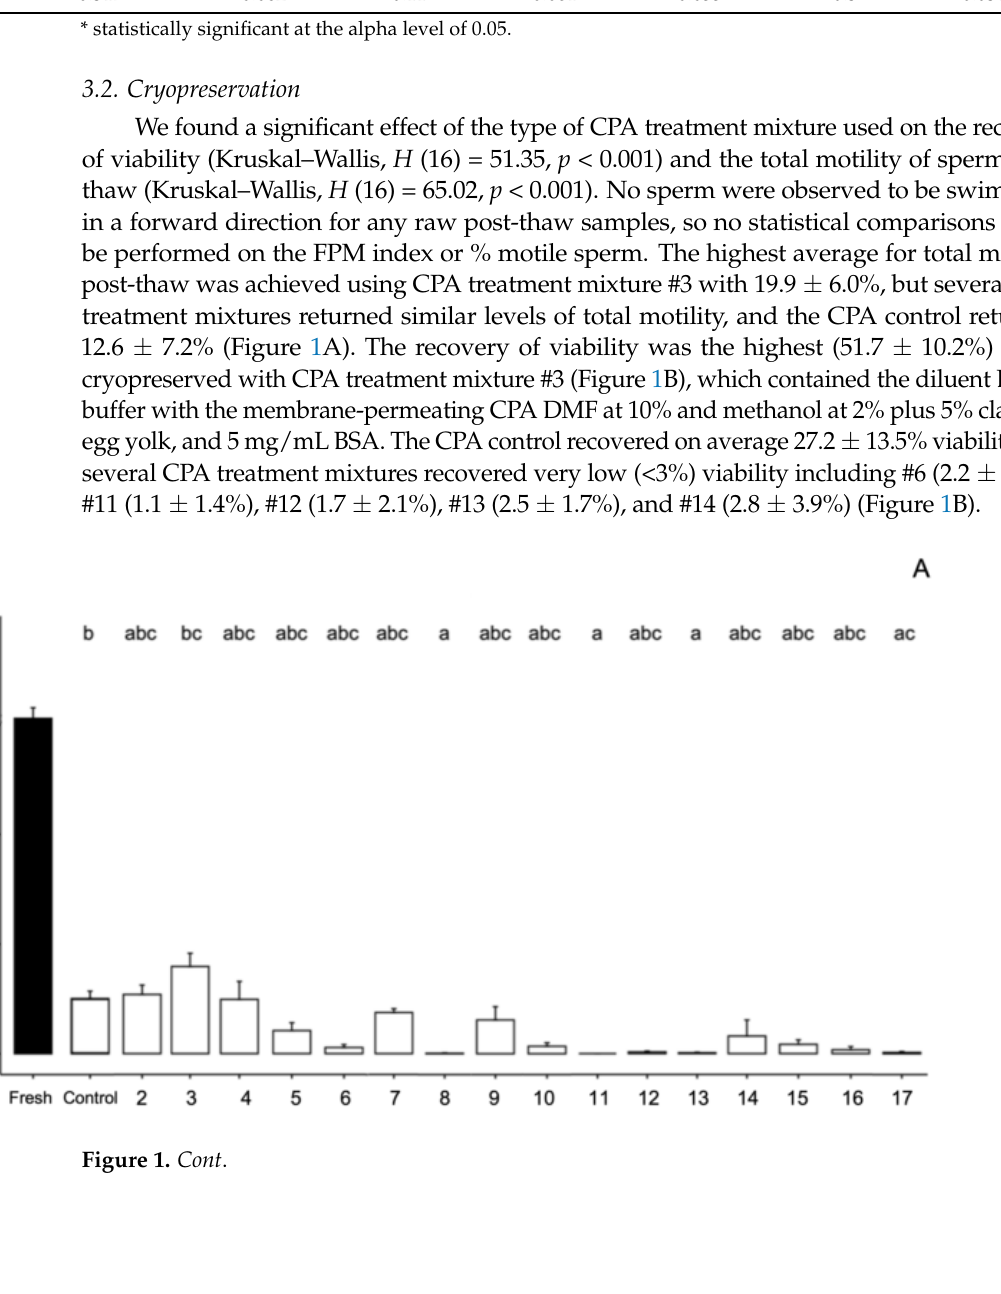
Figure 1. Barplot A: percent total motility of post-thaw sperm of the Louisiana pinesnake cryo- preserved using 17 different CPA treatment mixtures; B percent viability of thawed sperm recov- ered from fresh sperm. Full CPA treatment recipes are reported in Table 1 as final concentrations following a 1:1 dilution (v/v) with semen. Four randomized groupings of males were used to test the CPA control mixture (control) and a set of CPA treatment mixtures (Group A = CPAs #3, 4, 5, 7; Group B = CPAs #2, 14, 15, 16; Group C = CPAs #6, 11, 12, 13; Group D = CPAs #8, 9, 10, 17). We tested CPA mixtures based on three categories of experimental tests: CPA base in TEST = CPA #2; Extender base plus additives = CPAs #3 – 8; and glycerol tests (high vs low) = CPAs #9 – 17). The bars represent the means and standard deviation for each experimental group. Kruskal – Wallis tests for significance followed by Dunn’s post-hoc test with the Benjamini – Hochberg correction for multiple comparisons to compare CPA treatments; alpha was set at 0.05. The letters above each bar represent significantly different groups, and the black filled bars represent fresh samples and were not in- cluded in the statistical tests. 3.3. Post-Thaw Additives The effect of sperm dilution post-thaw in H10 with or without caffeine was not uni- form across the measures of motility. Percent total motility was not significantly different following incubation in either post-thaw treatment (Kruskal – Wallis, H (2) = 0.32, p = 0.851) (Figure 2A). However, both the percent of motile sperm found to be moving forward (Kruskal – Wallis, H (2) = 18.2, p < 0.001),) and FPM index (Kruskal – Wallis, H (2) = 18.8, p <